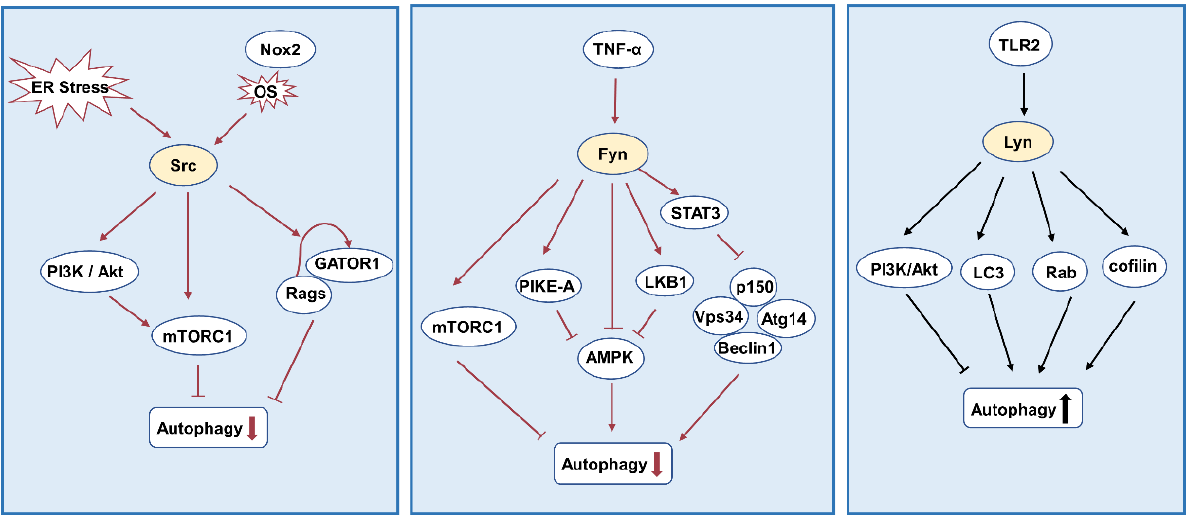
Figure 5. Src family kinases and autophagy. Src and Fyn inhibit autophagy through mTORC. Fyn also reduces autophagy by inhibiting AMPK phosphorylation. Lyn may have a two-sided effect